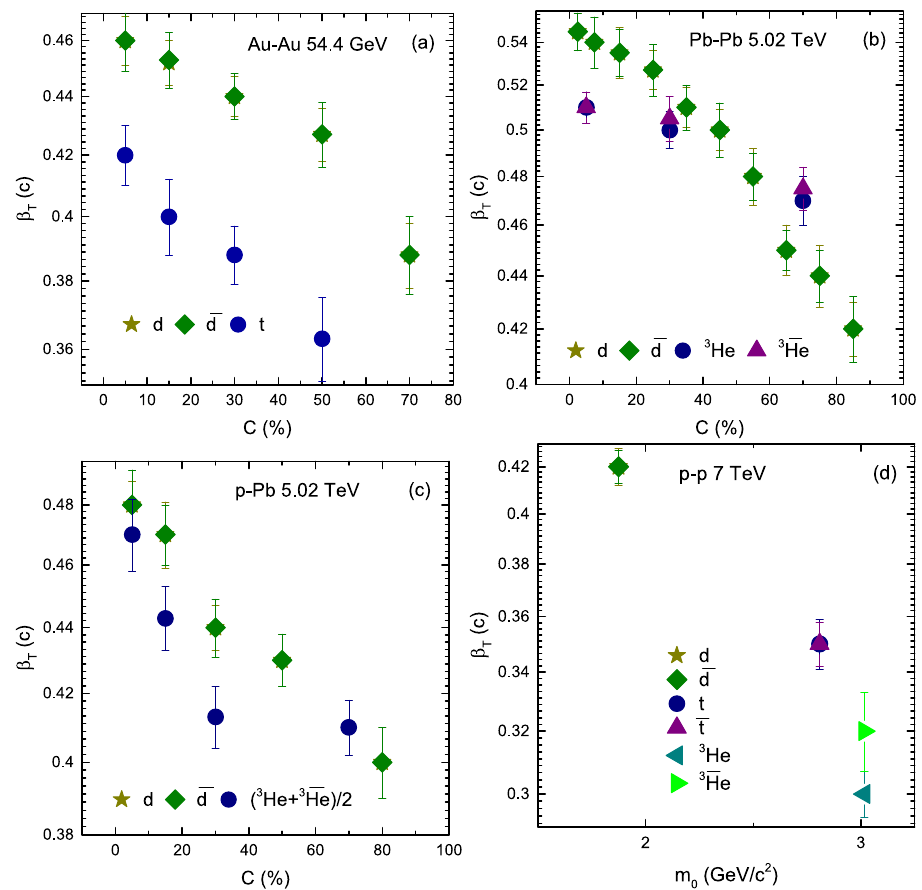
¯ 3 He ¯ d , t , ¯ t , 3 He and or